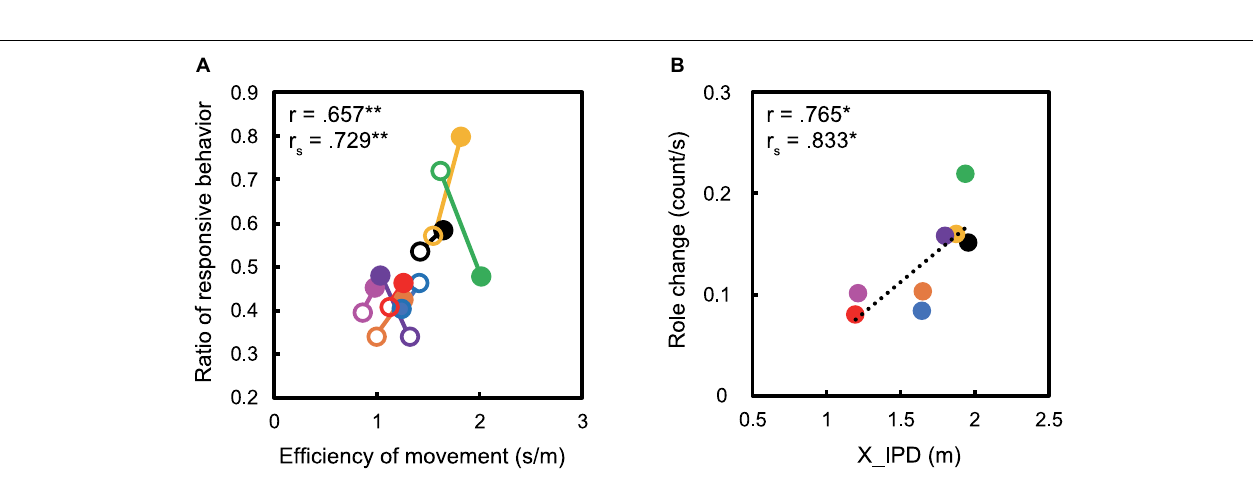
FIGURE 6 | Relationship of the individual and pair behavior indicators in the physical task with those in the cognitive task. Panel (A) shows the relationship between the individual behavior indicator in the 3-on-2 tag game and the pair activities in the math classes. The horizontal axis shows the time it takes to move 1 m of an individual’s efficiency of movement in the 3-on-2 tag game. The vertical axis shows the ratio of responsive behavior in the pair activity. Panel (B) shows the relationship between the pair behavior indicator in the 3-on-2 tag game and the pair activities in the math classes. The horizontal axis shows the X_IPD of the game, and the vertical axis shows the role change in the pair activity. * P < 0.05, ** P <